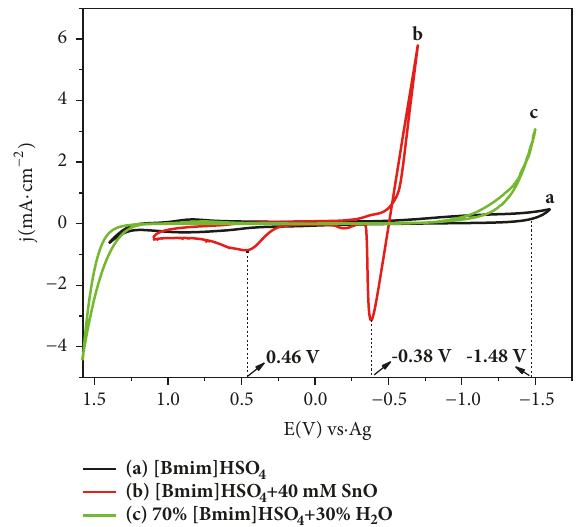
Figure 1: Cyclic voltammograms recorded at GC electrode in [Bmim]HSO 4 : (a) pure [Bmim]HSO 4 , (b) [Bmim]HSO 4 containing 40mM SnO, and (c) [Bmim]HSO 4 containing 30% (v/v) H 2 O. Scan rate: 50mV/s, 353K.